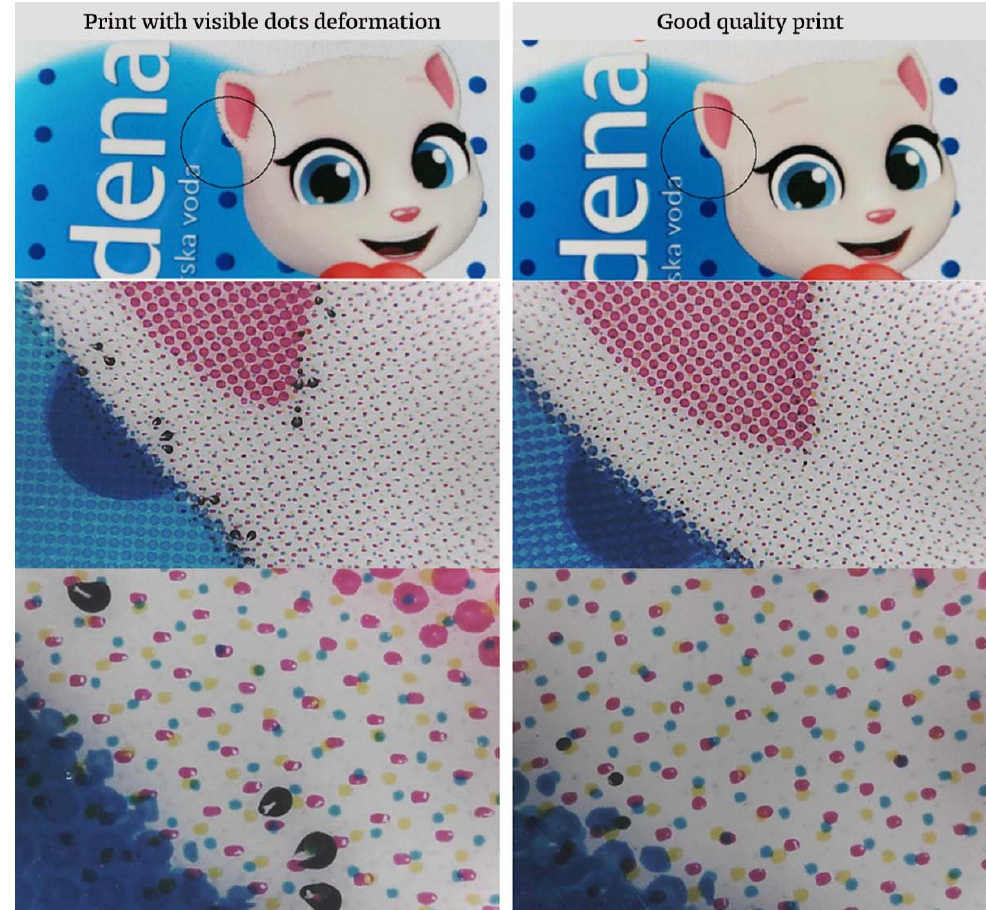
Figure 9. Display of the deformation of dots on the print at two states of printing. On microscopic images, dot deformations in a black color, visible as a dirty print, can be easily detected. However, the cause is related to defining the anilox roller line screen, (i.e., defining the minimum dot in the print). The minimum dot is the smallest dot that can be well reproduced in a defined printing process